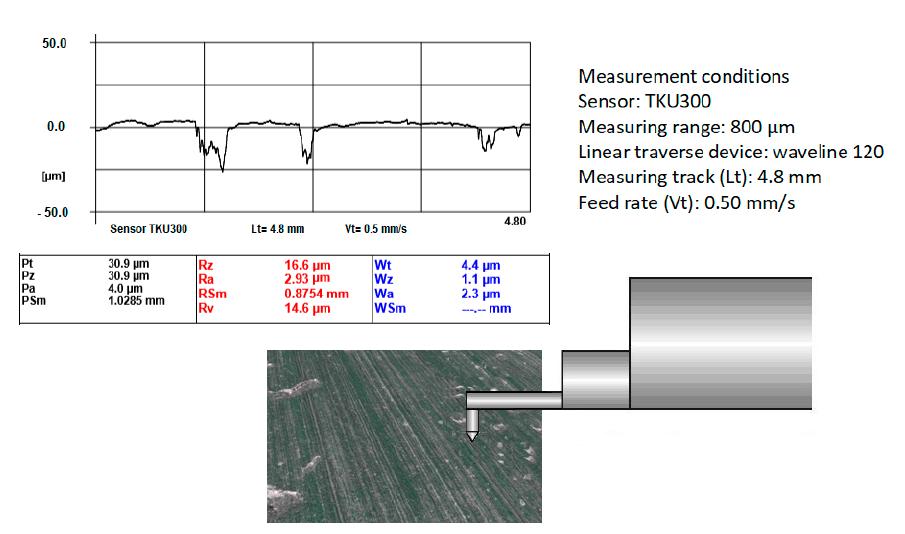
Figure 4. Measurement of surface roughness (real